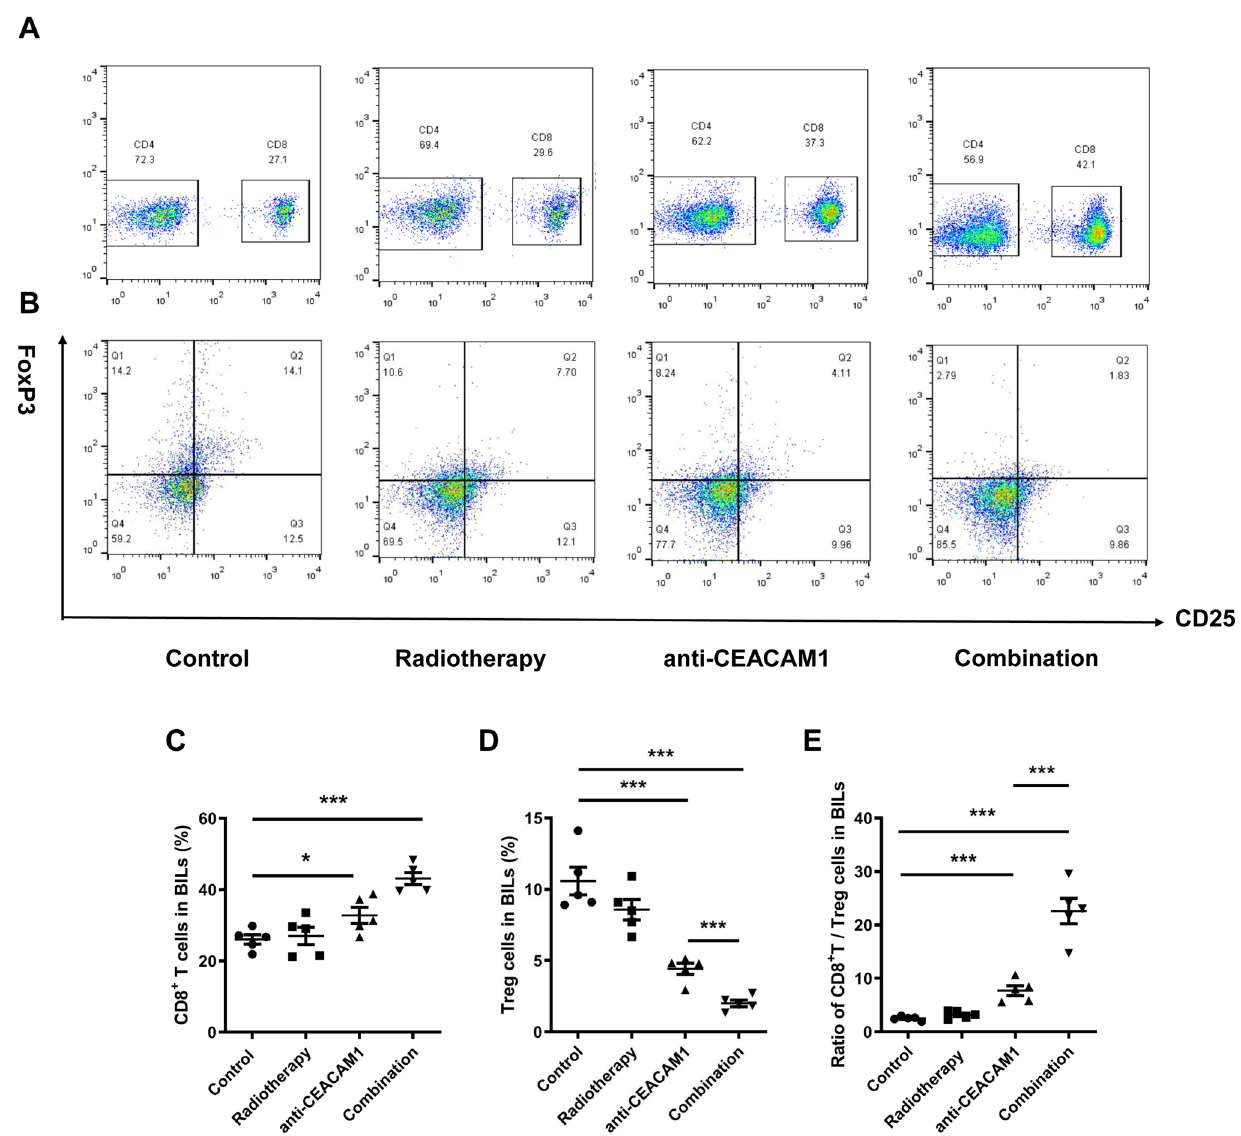
Fig. 4 Percentage of CD8 + T-cells in BILs, percentage of Treg cells in BILs, and ratio of CD8/Treg detected by flow cytometry in mice of differ- ent groups. A and B Representative images of flow cytometry illustrating the percentage of CD8 + T-cells in BILs and the percentage of Treg cells in BILs in mice of different groups. C Statistical graph on the percentage of CD8. + T-cells. D Statistical graph on the percentage of Treg cells. E Statistical graph on the ratio of CD8/Treg. *: P < 0.05, ***: P <